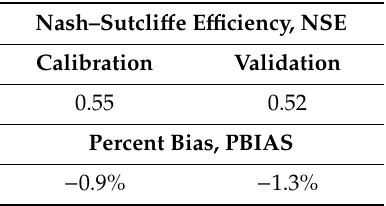
Table 9. SWAT model calibration objective